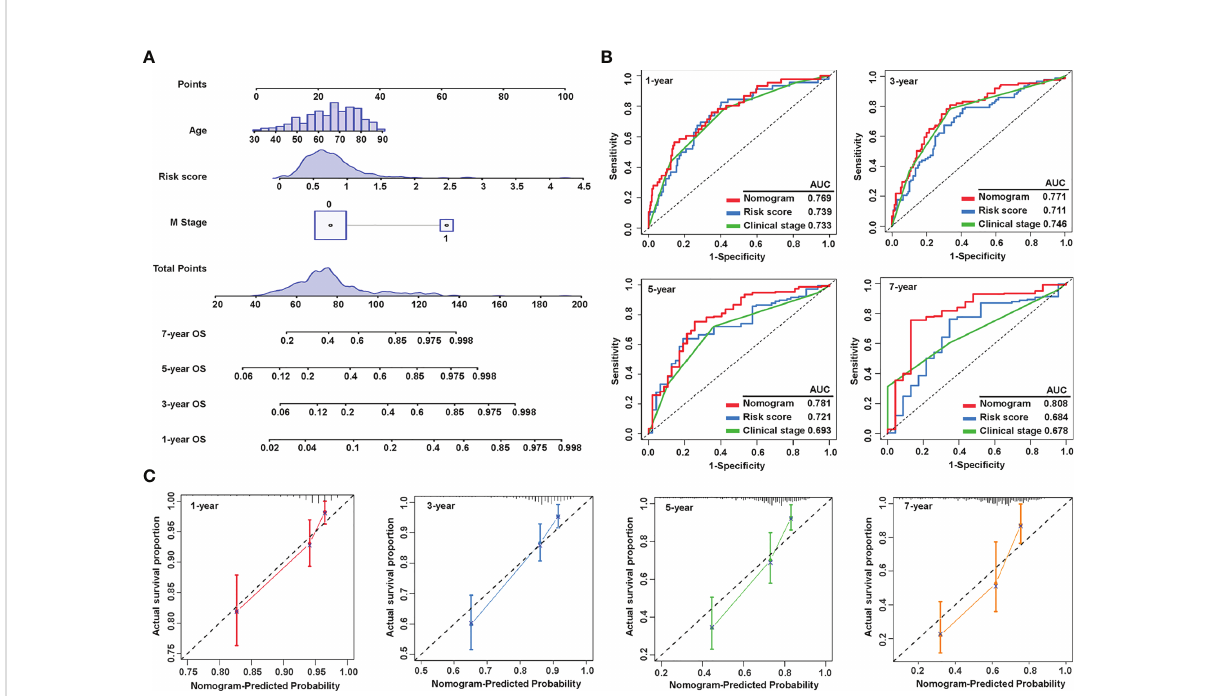
FIGURE 5 Construction and evaluation of the nomogram. (A) Nomogram constructed by three independent prognostic factors (risk score, metastatic (M) stage, and age) predicts 1-, 3-, 5-, and 7-year overall survival. (B) ROC curves show the predictive accuracy of the nomogram, risk score, and the clinical stage. (C) Calibration curves for 1-, 3-, 5-, and 7-year survival. ROC, receiver operating characteristic; and AUC, area under the